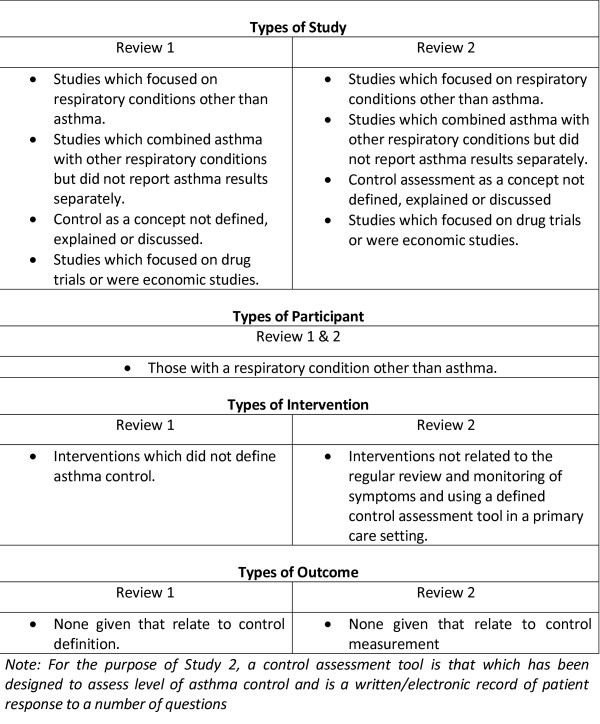
Exclusion criteria for studies in the systematic review.